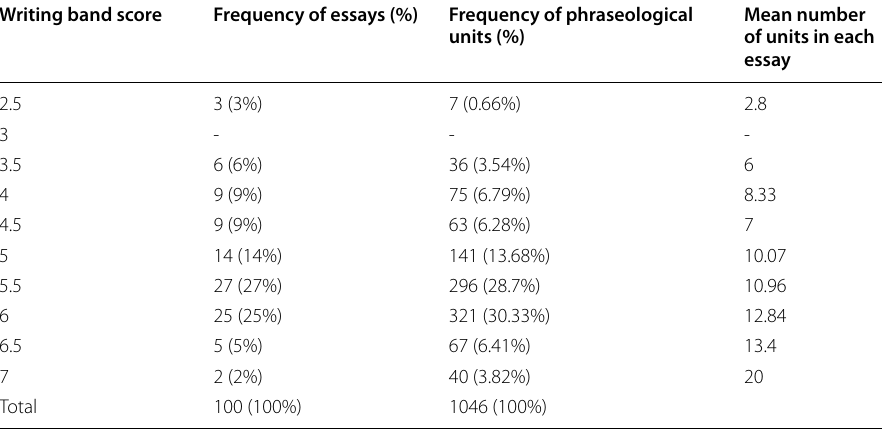
Table 8 Frequency counts and mean number of the units used in each band score Writing band score Frequency of essays (%) Frequency of phraseological